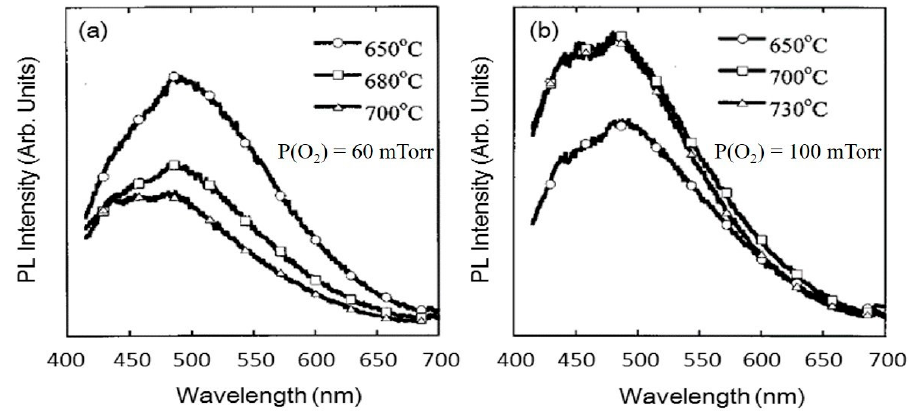
Figure 11. PL emission spectra of ZnGa 2 O 4 films on MgO(100) substrates using an area portion of ZnGa 2 O 4 /ZnO of 50%/50% target with various substrate temperatures under total P(O 2 ) of ( a ) 60 and ( b ) 100 mTorr [79] (with copyright permission from AIP Publishing, 2020).